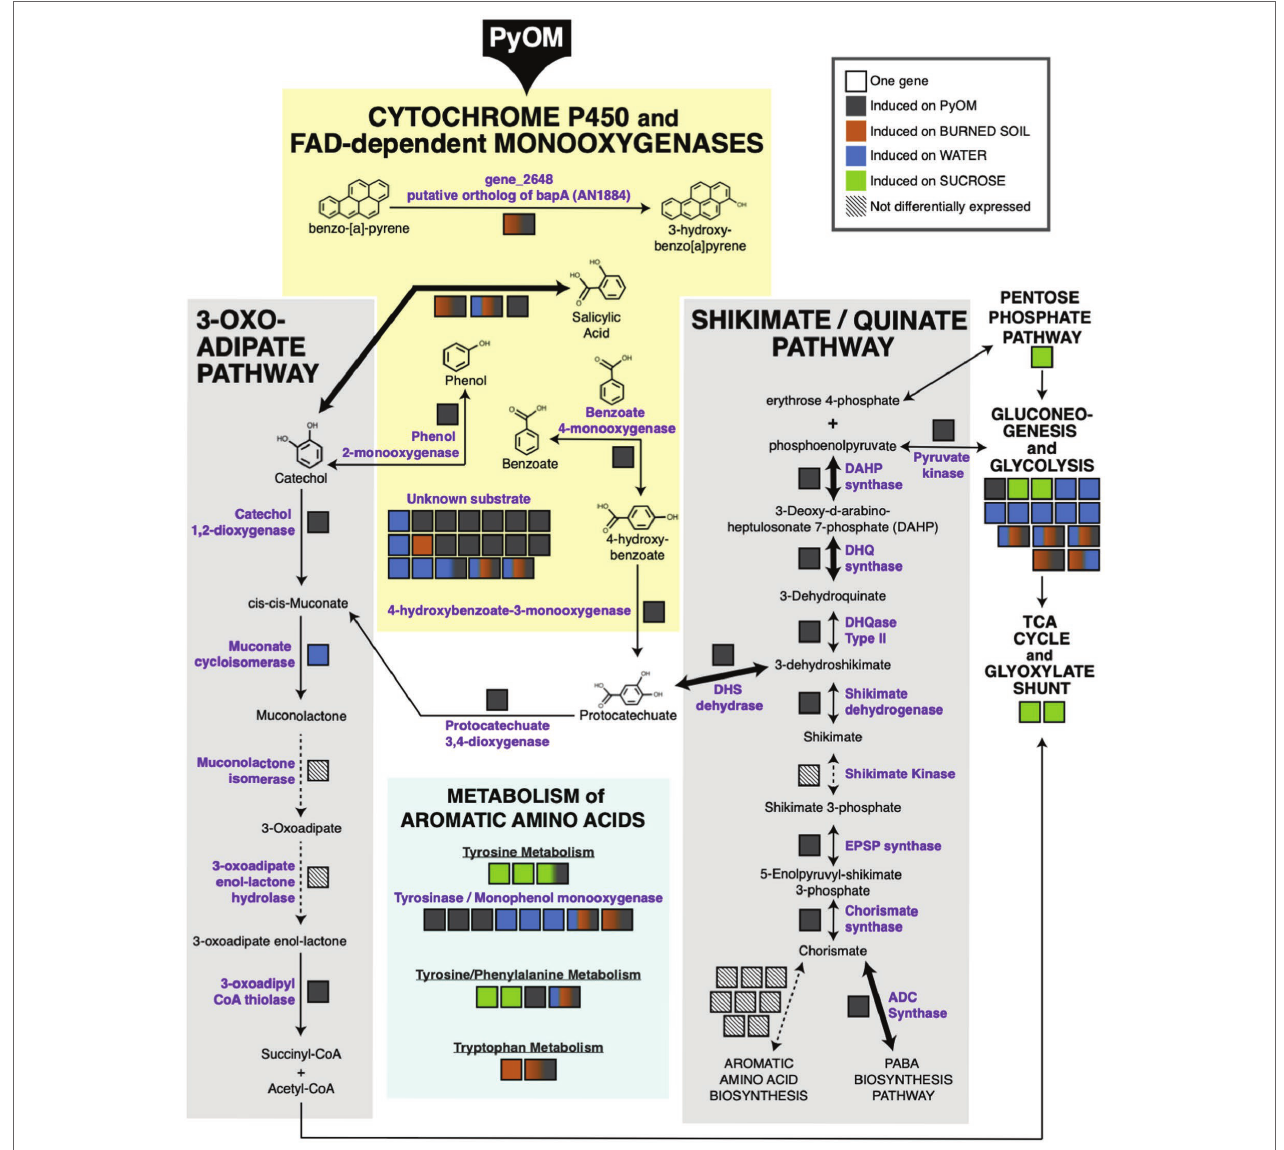
FIGURE 4 | Metabolic map highlighting aromatic compound metabolism induced by growth on pyrolyzed substrates. Significantly upregulated genes mapped onto the canonical pathways for aromatic compound metabolism (adjusted value of p < 0.01, fold change > 2, n = 3). Bolded arrows indicate a fold change > 8 on PyOM compared to sucrose. Each gene is indicated as a black-outlined box, and the proteins encoded by these genes are indicated as purple text. The color fill of the box indicates the condition(s) in which the gene was upregulated. Multi-colored boxes are slightly larger than mono-color boxes to increase visibility of the colors and to highlight genes that are induced in more than one condition. Diagonal parallel lines within a box and associated dashed lines indicate genes that were expressed, but not differentially expressed under the tested